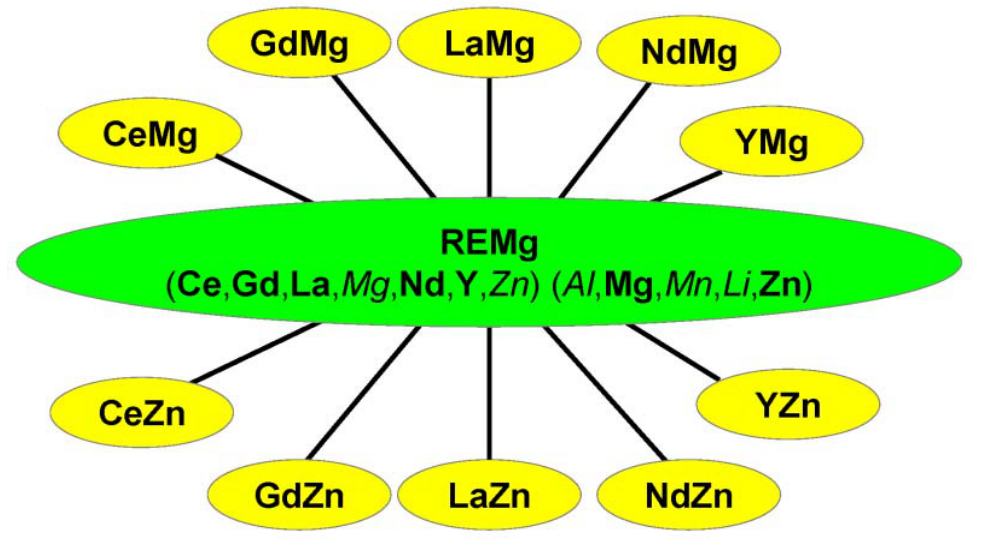
Figure 3. Sketch of the unified model of the multicomponent phase REMg and its connection to all stable binary